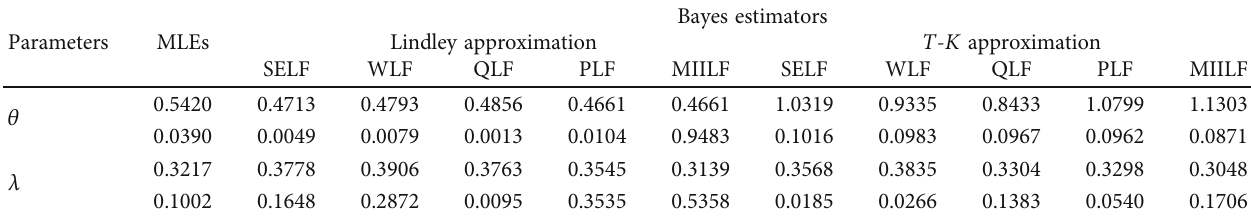
Table 4: The MLEs and Bayes estimates of θ and λ under di ff erent loss functions using electricity data set. Parameters